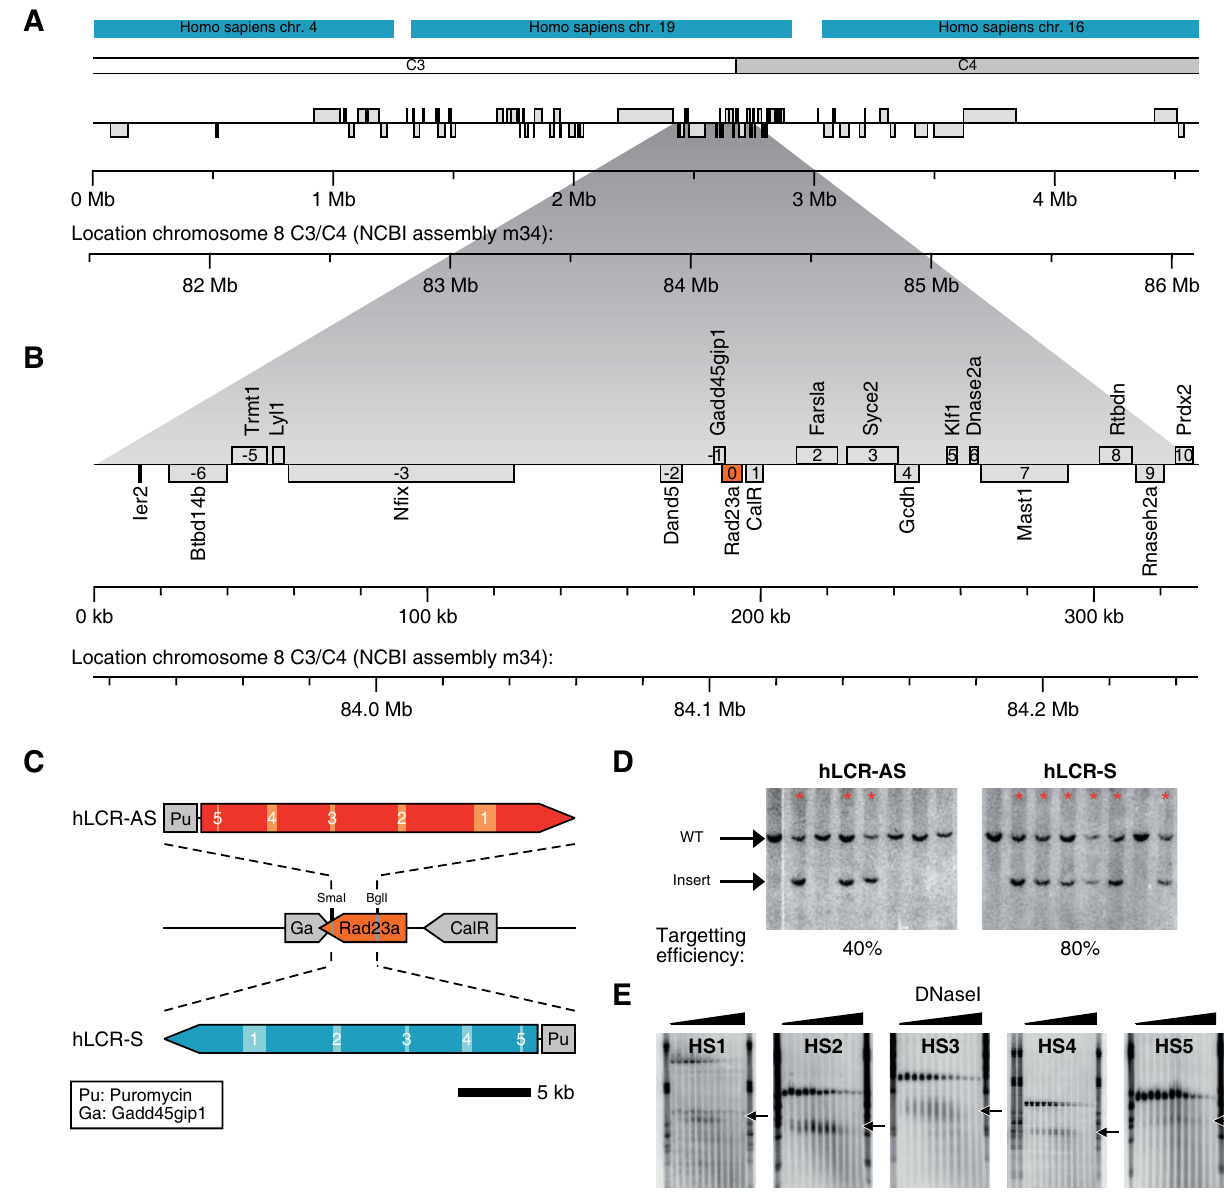
Figure 1. Targeting of the b -globin LCR into the murine gene-dense region 8C3/C4. (A) 3 Mb region containing 79 genes (NCBI assembly m34). Location on murine chromosome 8 is depicted below the region. Human synteny and cytogenic chromosome bands are depicted on top. (B) Zoom in on 300 kb region containing 18 genes characterized in this study (NCBI assembly m34). Genes are numbered relative to the center gene Rad23a (gene 0). Location on murine chromosome 8 is depicted below the region. (C) The full human b -globin LCR, linked to a puromycin selection marker, was integrated in sense orientation (LCR-S, blue) and anti-sense orientation (LCR-AS, red) relative to Rad23a , removing exons II–VII from the Rad23a gene. Hypersensitive sites (HSs) in the LCR are numbered and represented by shaded boxes. (D) Southern blot showing targeting of the LCR into the Rad23a locus. Positive clones are indicated by red arrows. Note that targeting is extremely efficient. (E) DnaseI hypersensitivity of HSs in the integrated LCR in the sense orientation. E14.5 fetal liver DNA was digested with increasing amounts of DnaseI and DNA fragments containing the respective HSs were visualized by Southern blotting. Hypersensitive DNA fragments are indicated by arrows. LCR-AS HSs showed comparable patterns (not